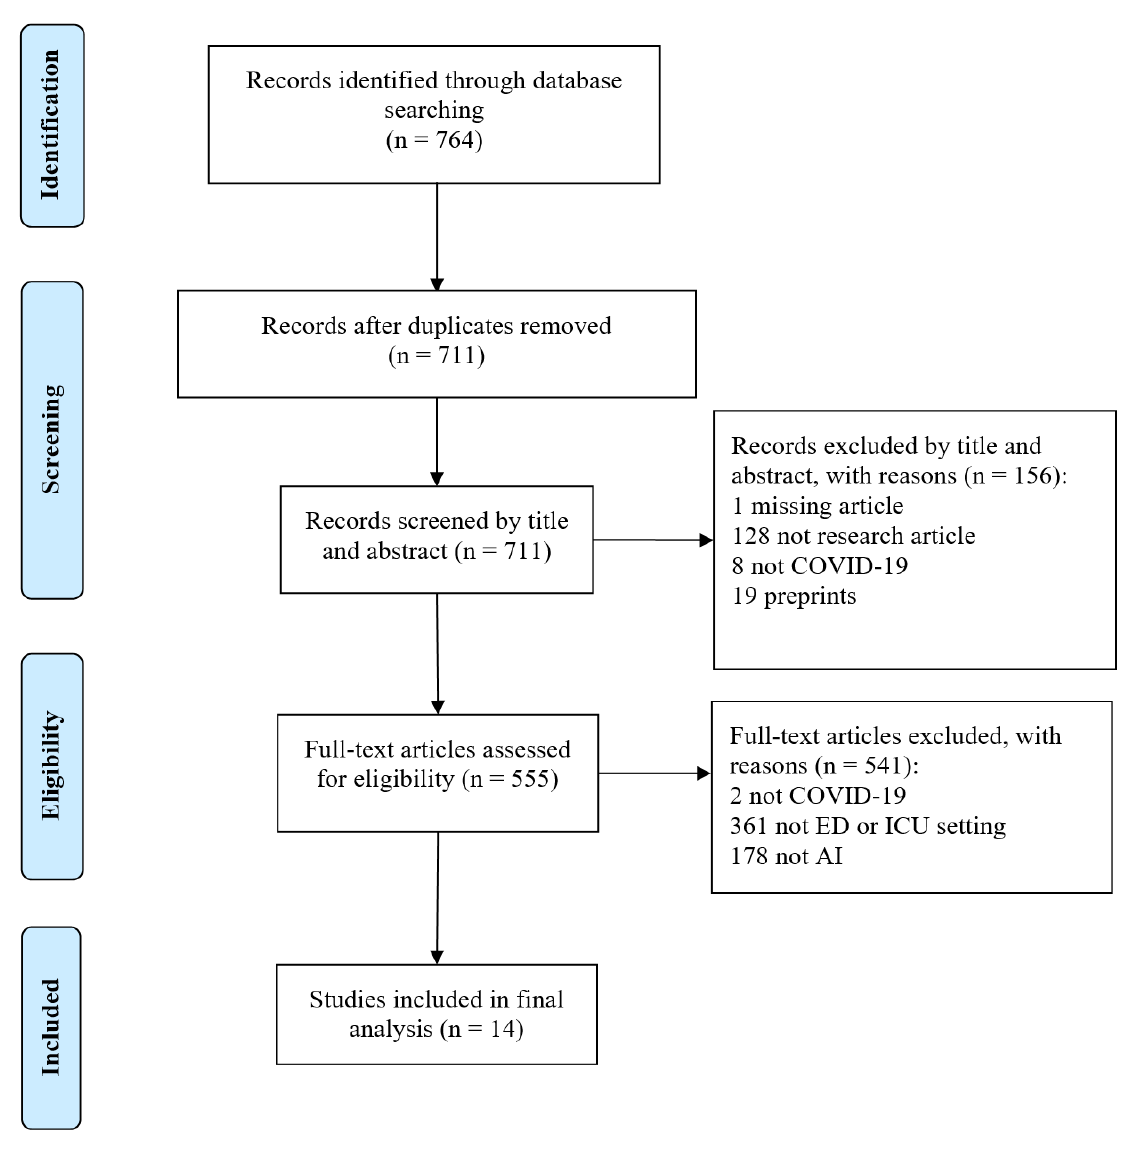
Figure 1. PRISMA flow diagram.